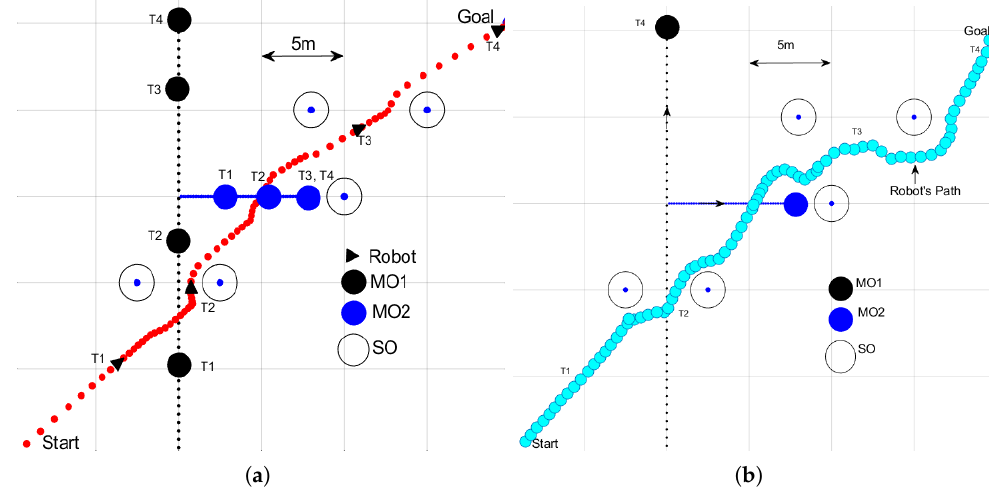
Figure 14. The ANADE and APF-TBM. The robot’s and obstacles’ locations at four different time instants T1–T4. ( a ) The robot’s path with the ANADE. ( b ) The robot’s path with the